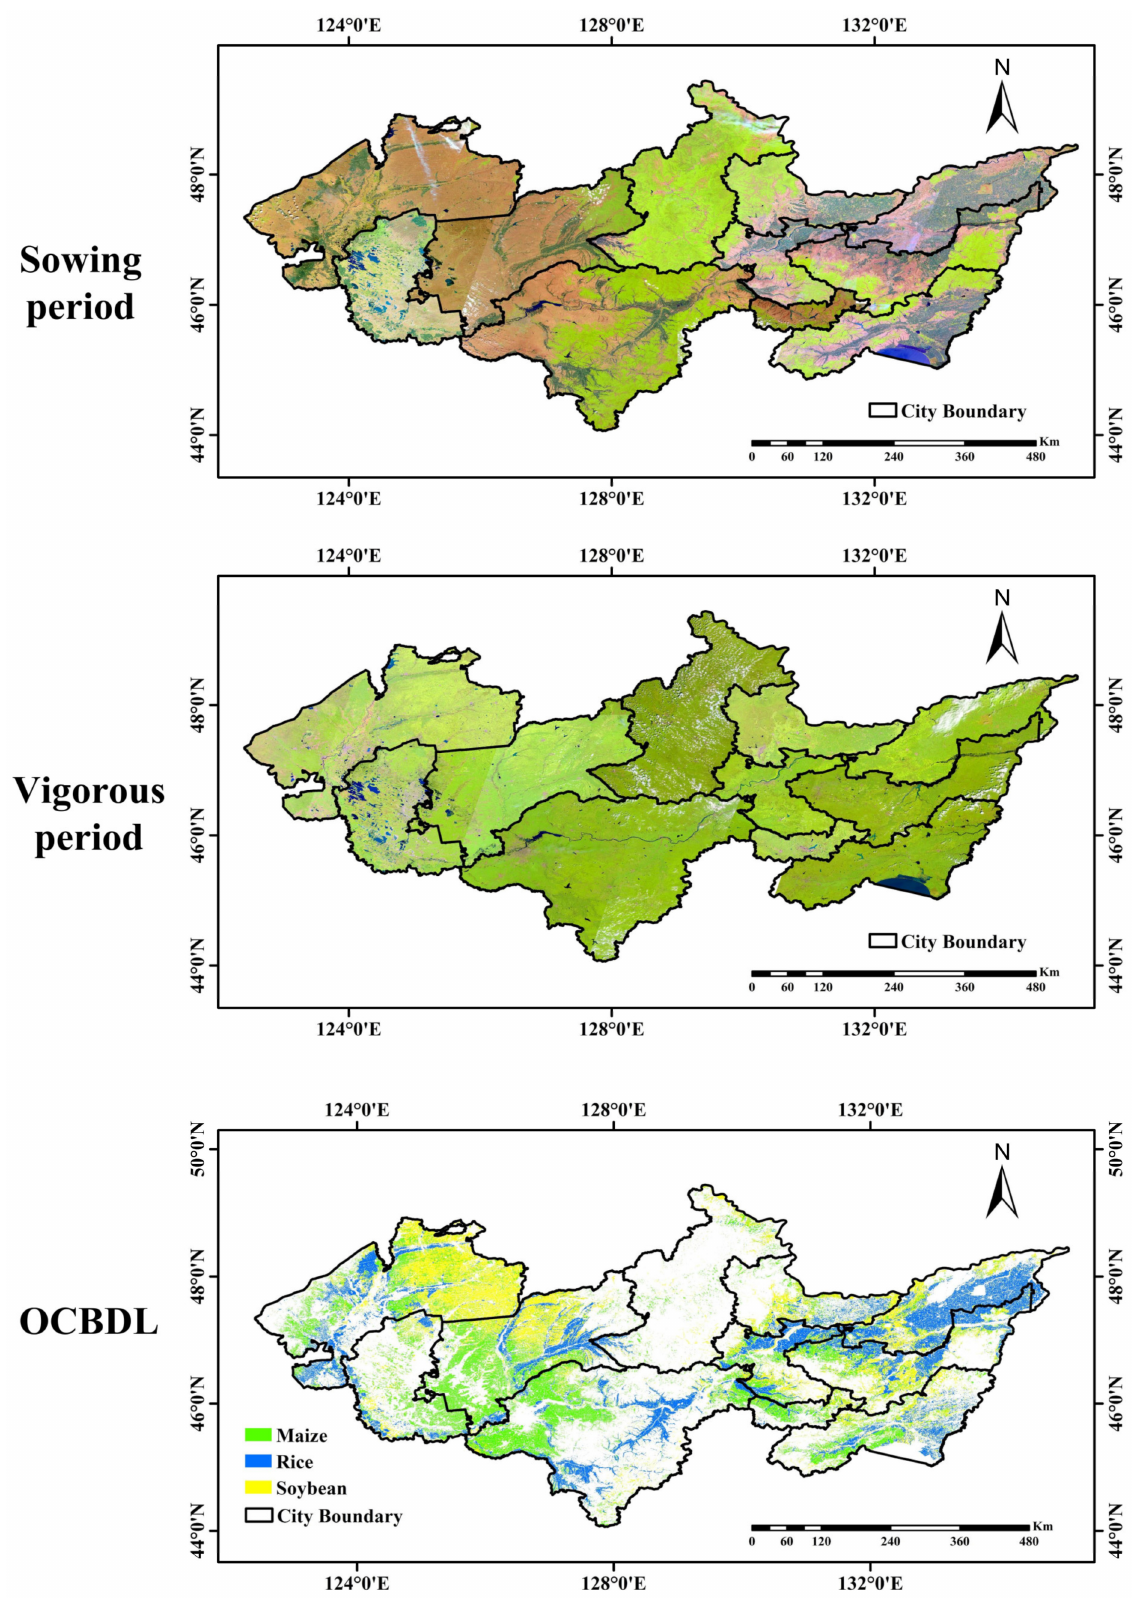
Figure 15. Sowing and vigorous images and OCBDL − estimated crop distribution in 11 cities in Heilongjiang